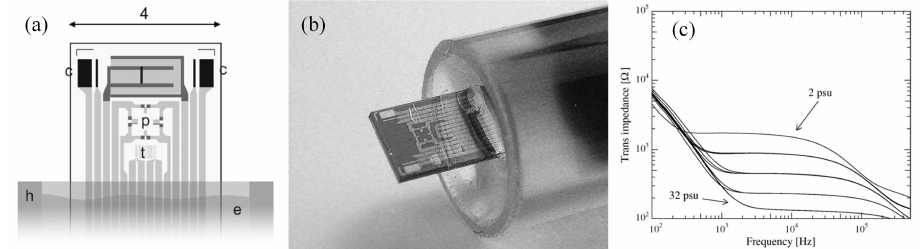
Figure 2. The micro CTD system for measurement of ocean water salinity. ( a ) The chip layout. ( b ) Photograph of finished chip. ( c ) Measured trans-impedance as a function of frequency for five different salinities (2, 4, 8, 16 and 32 psu). Reprinted from Publication [6], Copyright (2022), with permission from